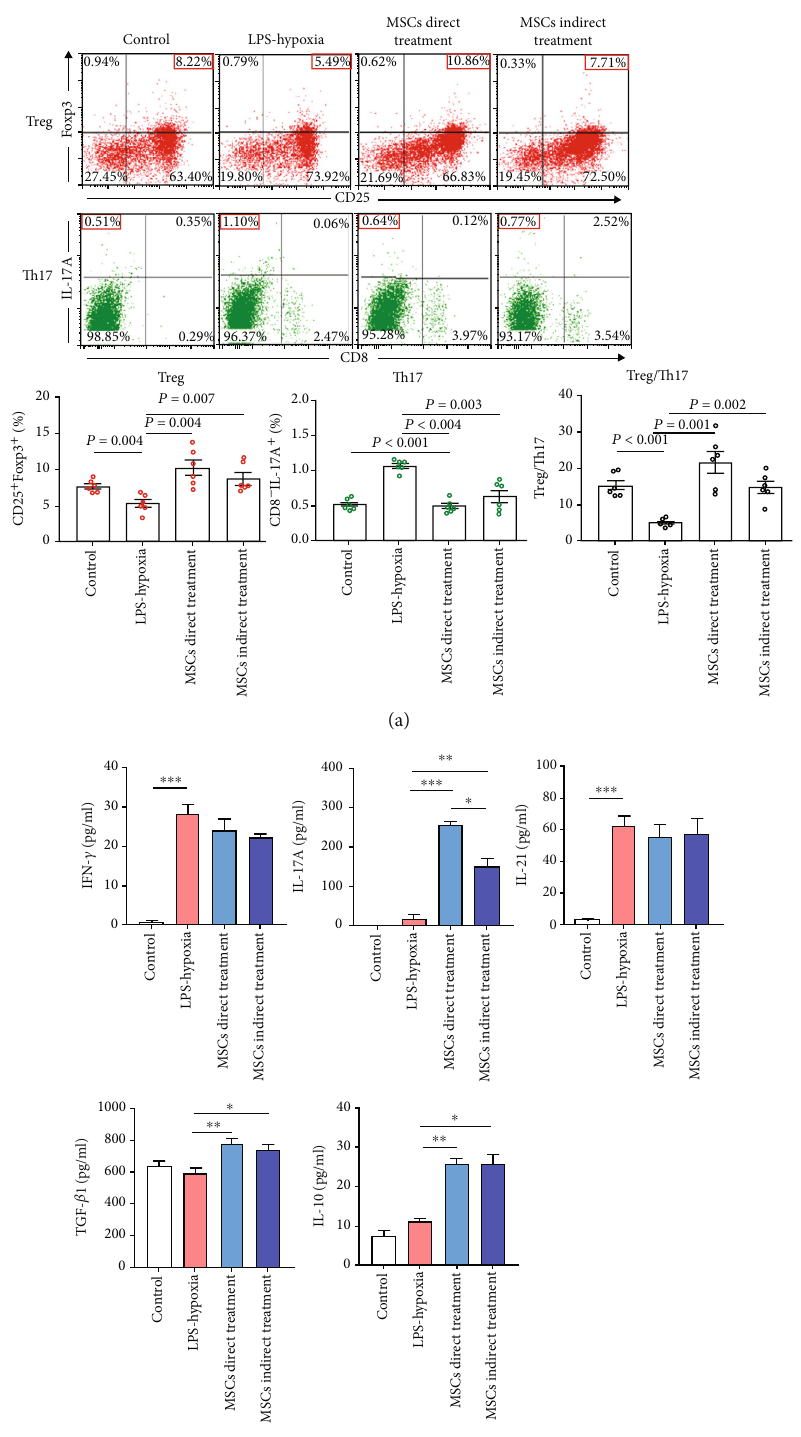
Figure 2: E ff ects of MSC on the skewed Treg/Th17 in LPS- and hypoxia-stimulated CD4 + T cells and cytokine secretion. CD4 + T cells alone ) stimulation (LPS-hypoxia), and MSC-treated CD4 + T cells with LPS-hypoxia (control), CD4 + T cells with LPS (100ng/ml)-hypoxia (5% O 2 challenge (MSC direct treatment and MSC indirect treatment) were cultured for 48 hours. (a) Then, cells were harvested for Treg and Th17 phenotypic identi fi cation by fl ow cytometry. Representative fl ow plots were shown. Bar graphs represent meanfrequency ± SEM of Treg and Th17 and mean values ± SEM of Treg/Th17 ratios in the various groups. (b) The culture supernatants were collected for IFN- γ , IL-17A, IL- 21, IL-10, and TGF- β 1 level measurement by an enzyme-linked immunosorbent assay, presented with mean ± SEM in the bar graph. ∗ P < 0 : 05 vs. the control group and ∗∗ P < 0 : 01 vs. the control group. IFN: interferon; IL: interleukin; LPS: lipopolysaccharide; MSC: mesenchymal stem cell; SEM: standard error of the mean; TGF: transforming growth factor; Th: T helper; Treg: regulatory T